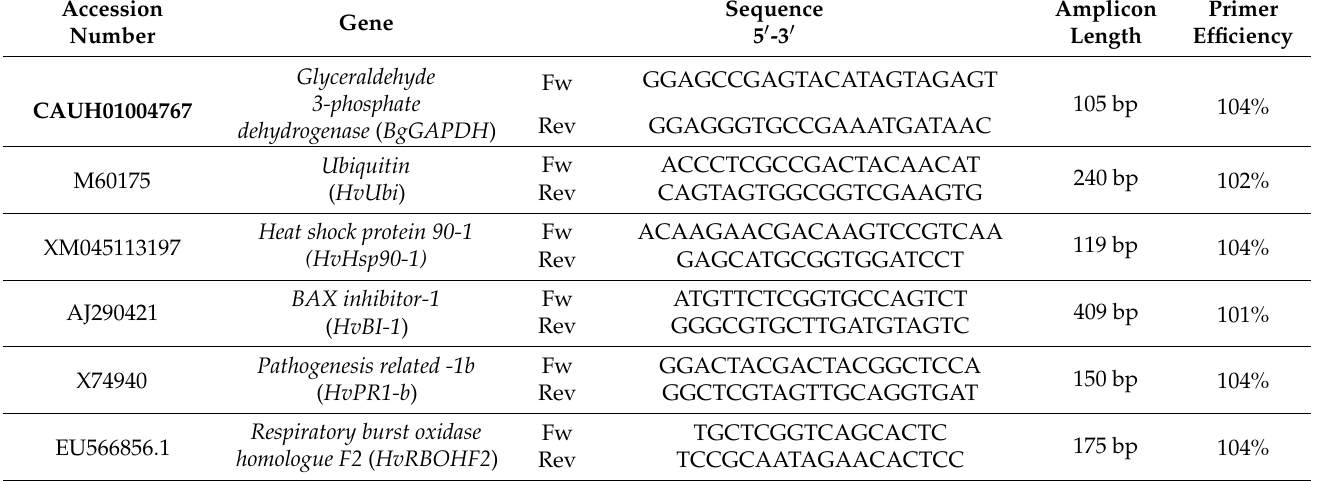
Table 1. Oligonucleotide primers used in